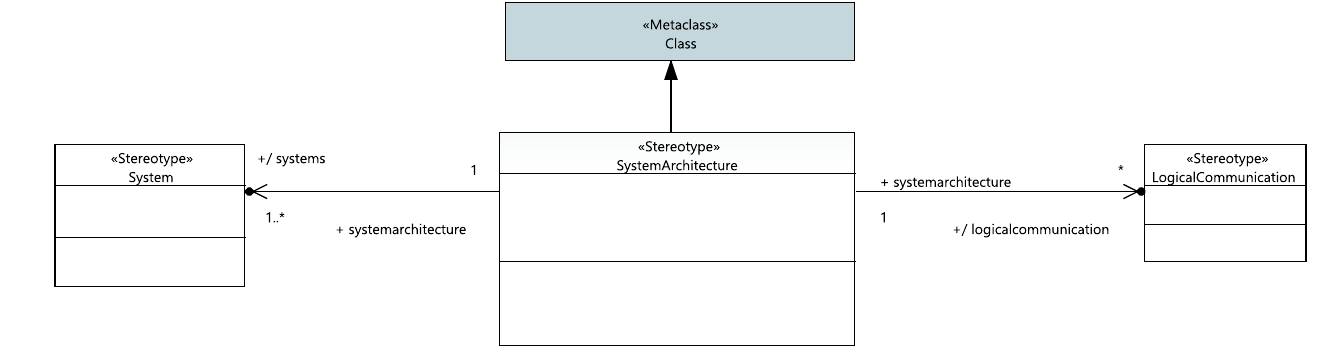
Figure 6. System Architecture